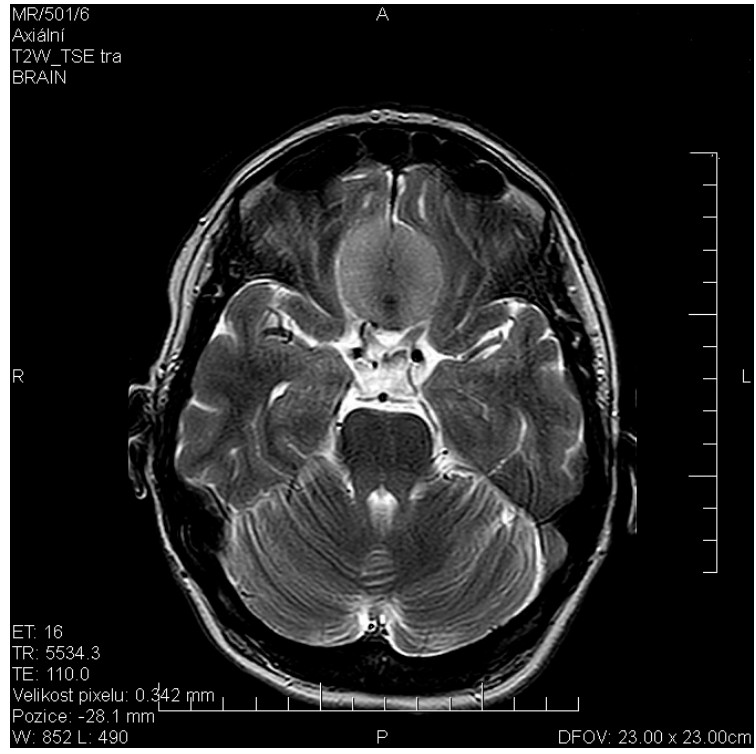
Figure 4. Magnetic resonance imaging (MRI) axial scan—olfactory meningioma—female, 48 years old (from co-author’s archive).